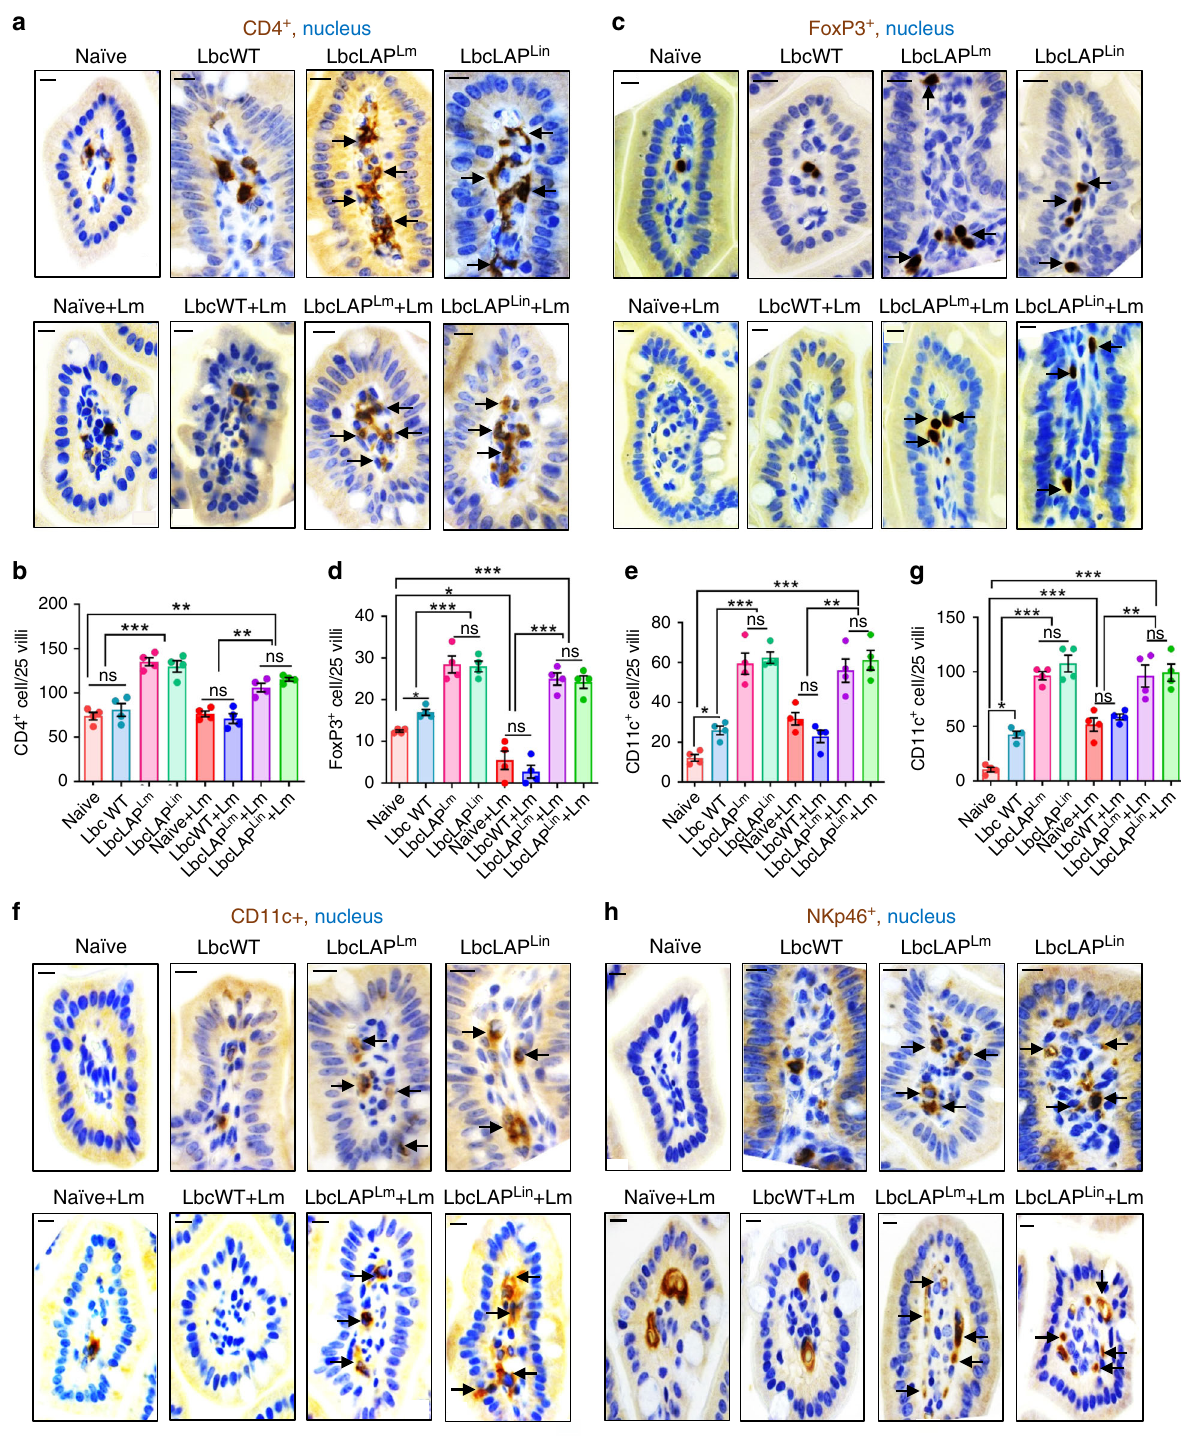
Fig. 9 BLP modulates immune cell populations to maintain intestinal immune homeostasis. a – h Representative immunohistochemical micrographs of ileal tissues showing increased CD4 + cells ( a , brown, arrows), FOXP3 + T-regulatory cells ( c , brown, arrows), CD11c + dendritic cells ( f , brown, arrows), and NKp46 + cells ( h , brown, arrows) in BLP-treated mice (10 days) mice pre- or post Lm challenge at 48 hpi, relative to naive or LbcWT-treated (10 days). Bars, 10 µ m. Quanti fi cation of CD4 + cells ( b ), FOXP3 + T-regulatory cells ( d ), CD11c + dendritic cells ( e ), and NKp46 + cells ( g ). Each point ( b , d , e , and g ) represents an average (mean ± SEM) of 25 villi from a single mouse, four mice per group, n = 100 villi. Statistical signi fi cance ( b , d , e , and g ) was determined by using the one-way ANOVA followed by a Tukey ’ s multiple comparisons. For all analysis, *** P < 0.001; ** P < 0.01; * P < 0.05; ns no signi fi cance. Source data are provided as a Source Data fi